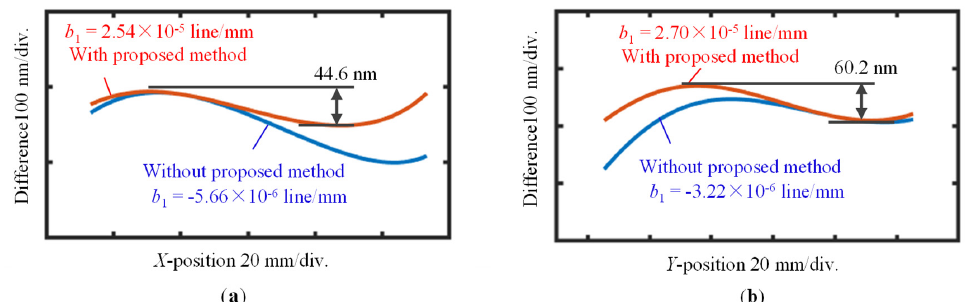
Figure 19. Differences between the encoder error of the absolute planar encoder and the accumulative results evaluated by using the assessed VLS parameter: ( a ) Differences between the comparison results along the X -direction with and without applying the proposed method; ( b ) Differences between the comparison results along the Y -direction with and without applying the proposed method.